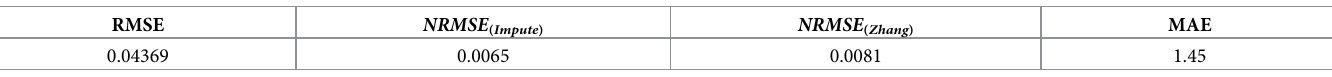
and Pred ð Zhang Þ on GDSC dataset. C C